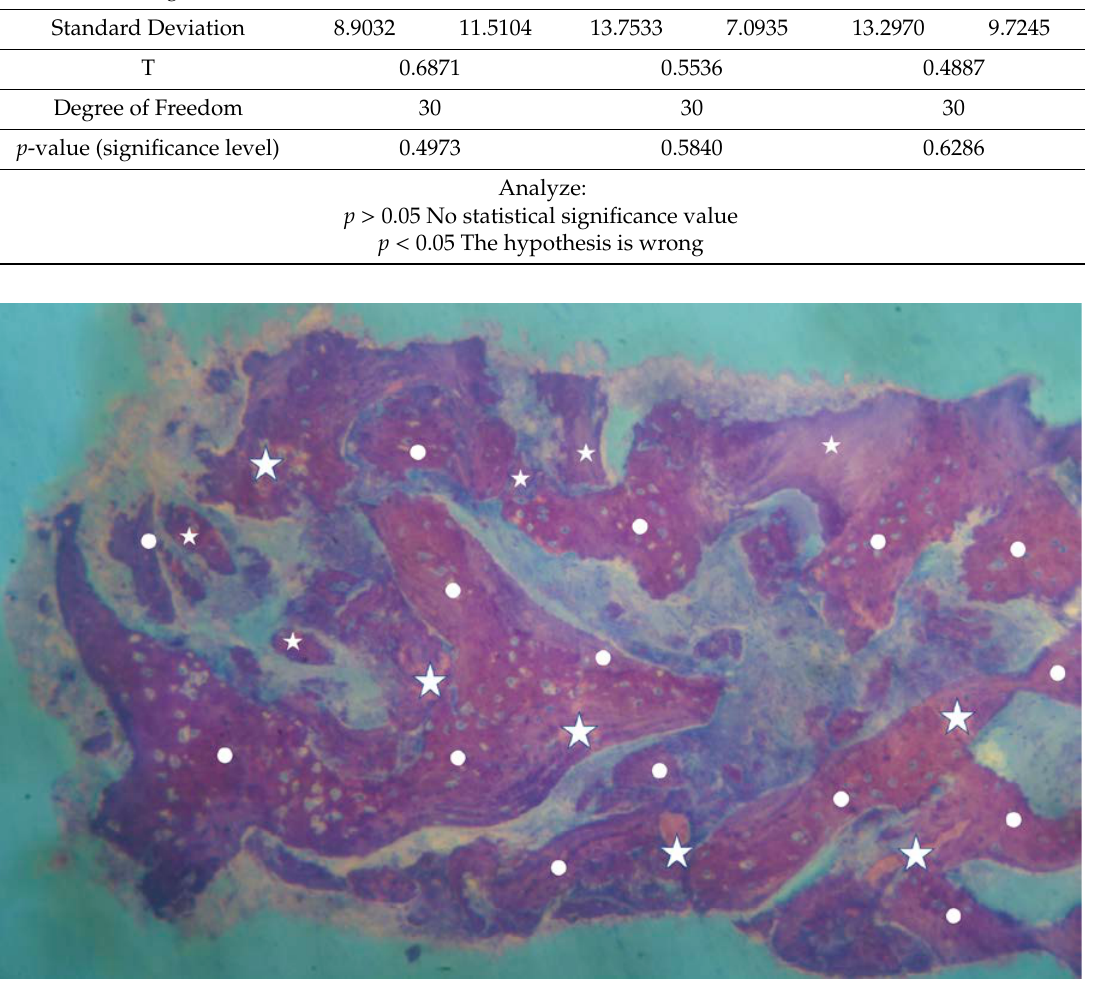
Figure 2. Overview of a biopsy at low magnification. Group 2: dentin matrix granules (indicated by white stars) and enamel granules (indicated by white squares) originating from endodontically